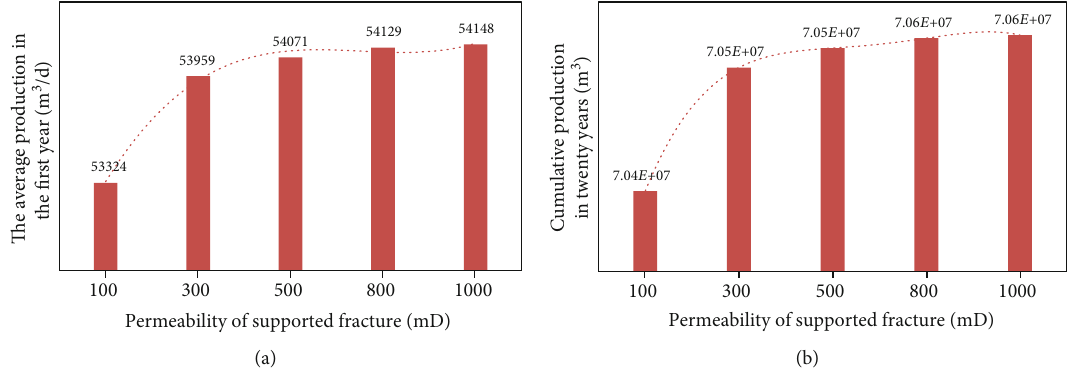
Figure 6: E ff ects of the permeability of supported fractures on gas production rate (a) and cumulative production